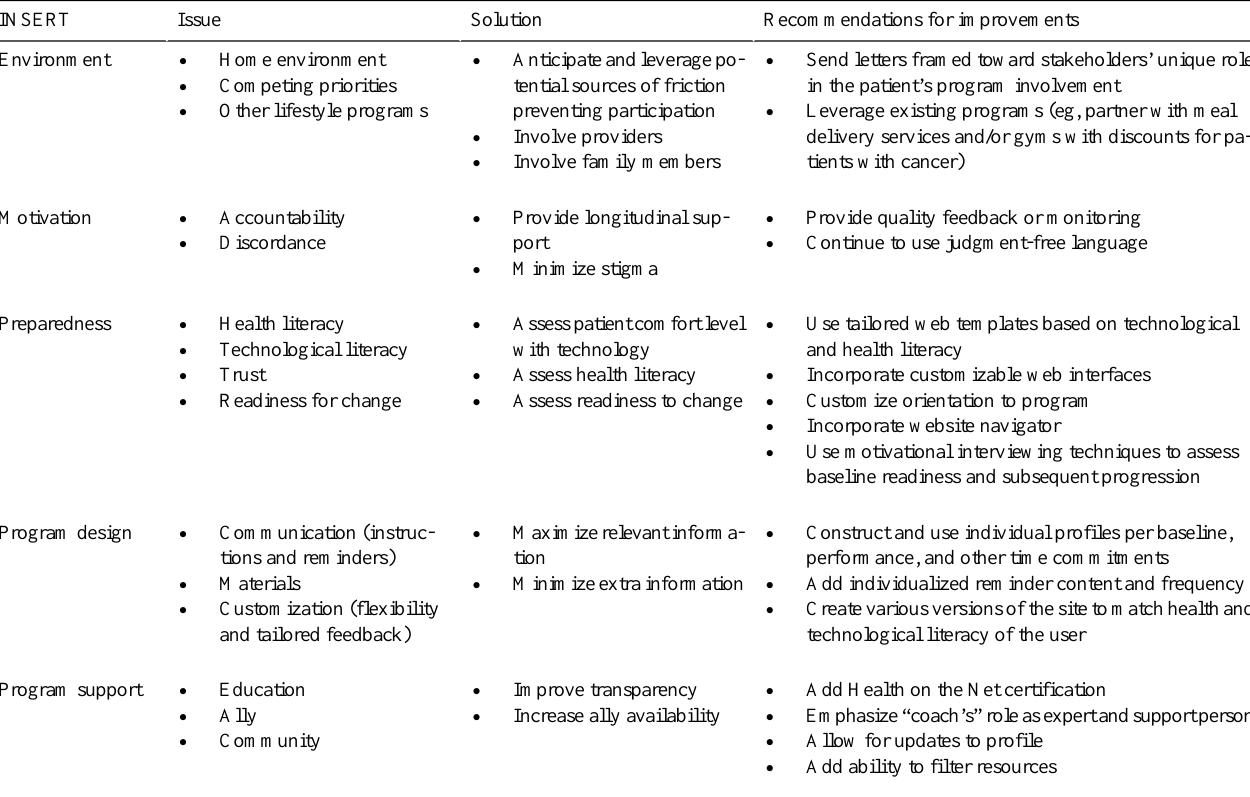
Table 2. Participant-inspired recommendations to improve intuitiveness and engagement with remotely delivered behavioral interventions for men with prostate